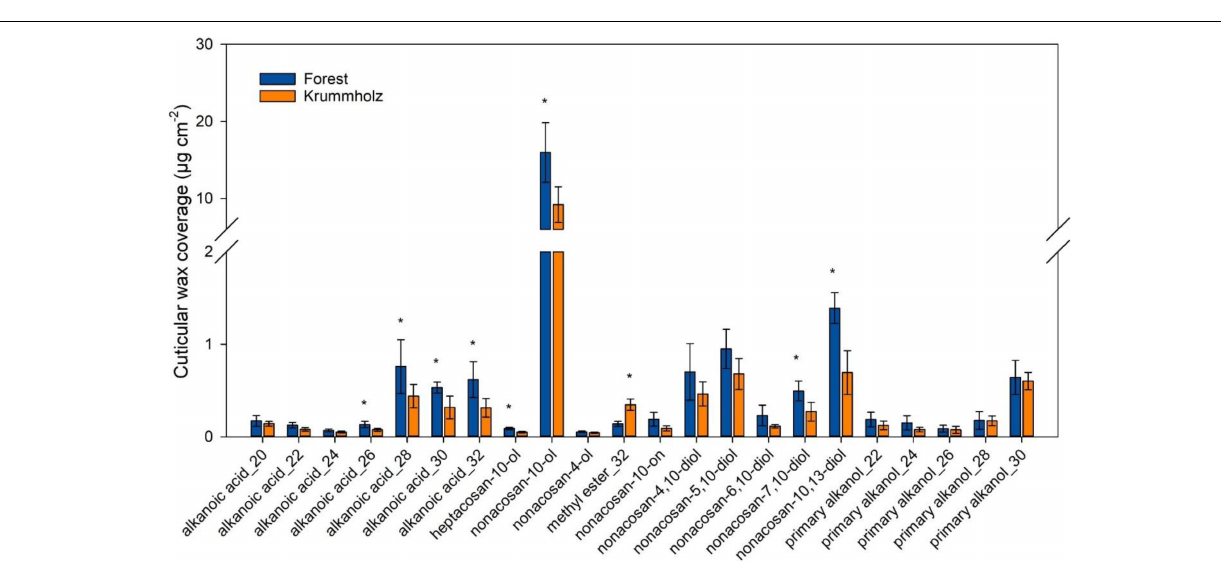
Frontiers in Plant Science |